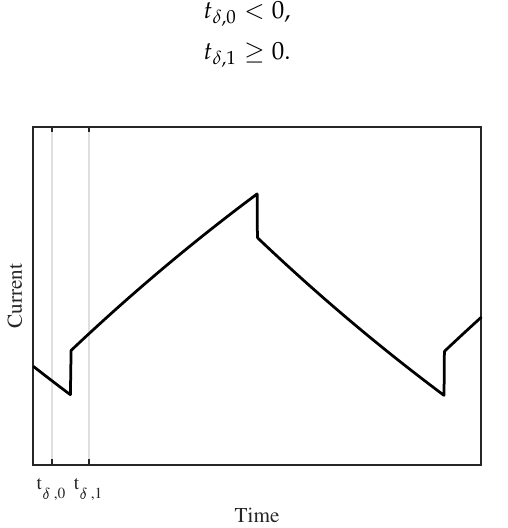
Figure 9. Current ripple with the proposed approximation of the eddy currents. The timings for the identification of the parallel resistance R p are indicated as t δ ,0 and t δ ,1